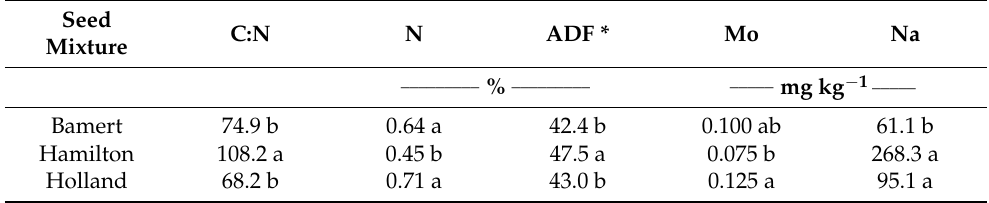
Table 2. Biomass properties by pollinator mixture measured at the Natural Resources Conservation Service Plant Materials Center in Booneville, AR in 2016 and 2017.